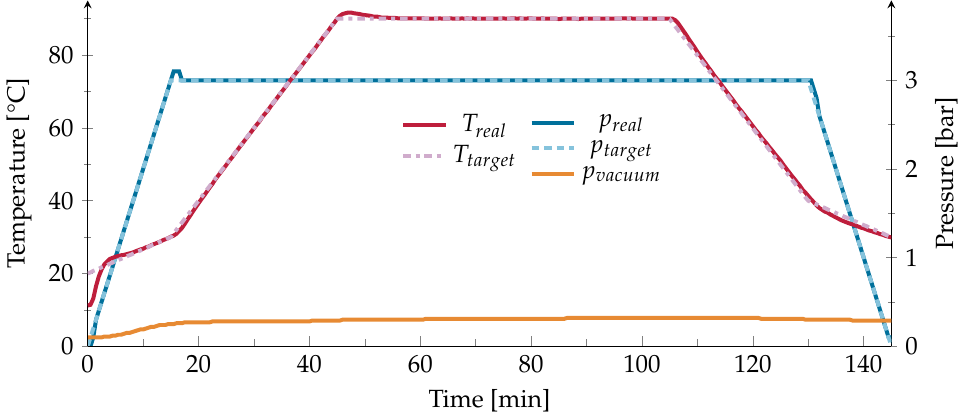
Figure 1. Protocol of the temperature T and pressure p for an annealing temperature of